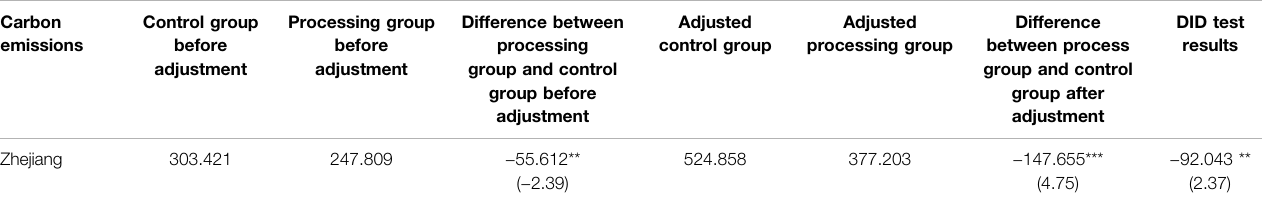
TABLE 6 | Robustness test for controlling other policy impacts.